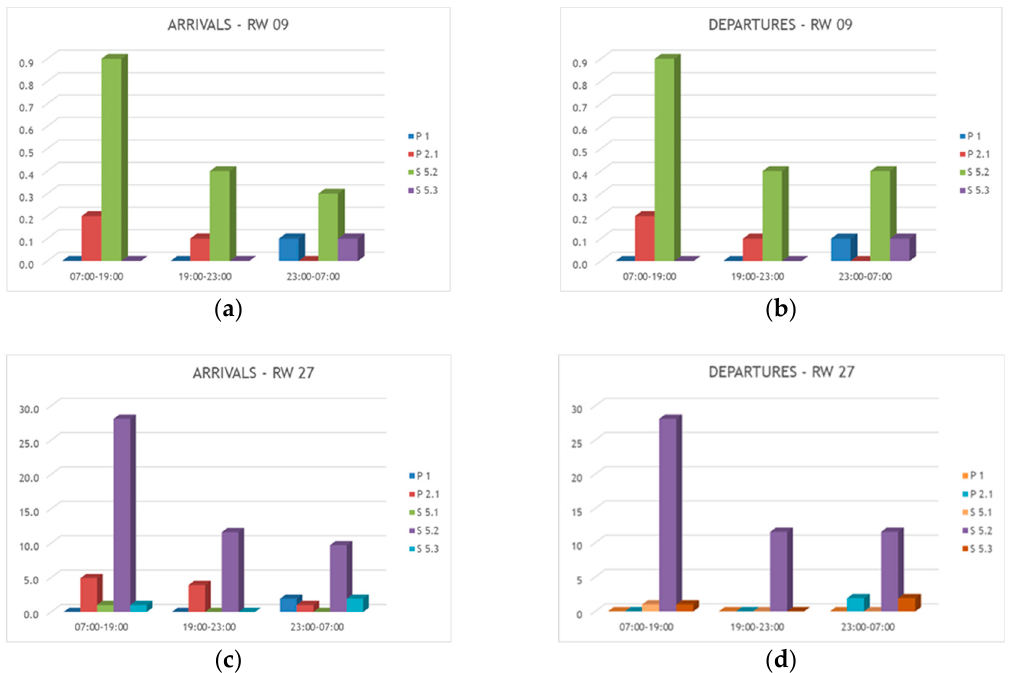
Figure 1. Annual average daily aircraft movements (TOffs & landings)—2012. Arrivals at RW 09( a ), departures at RW 09( b ), arrivals at RW 27( c ), departures at RW 27( d ).